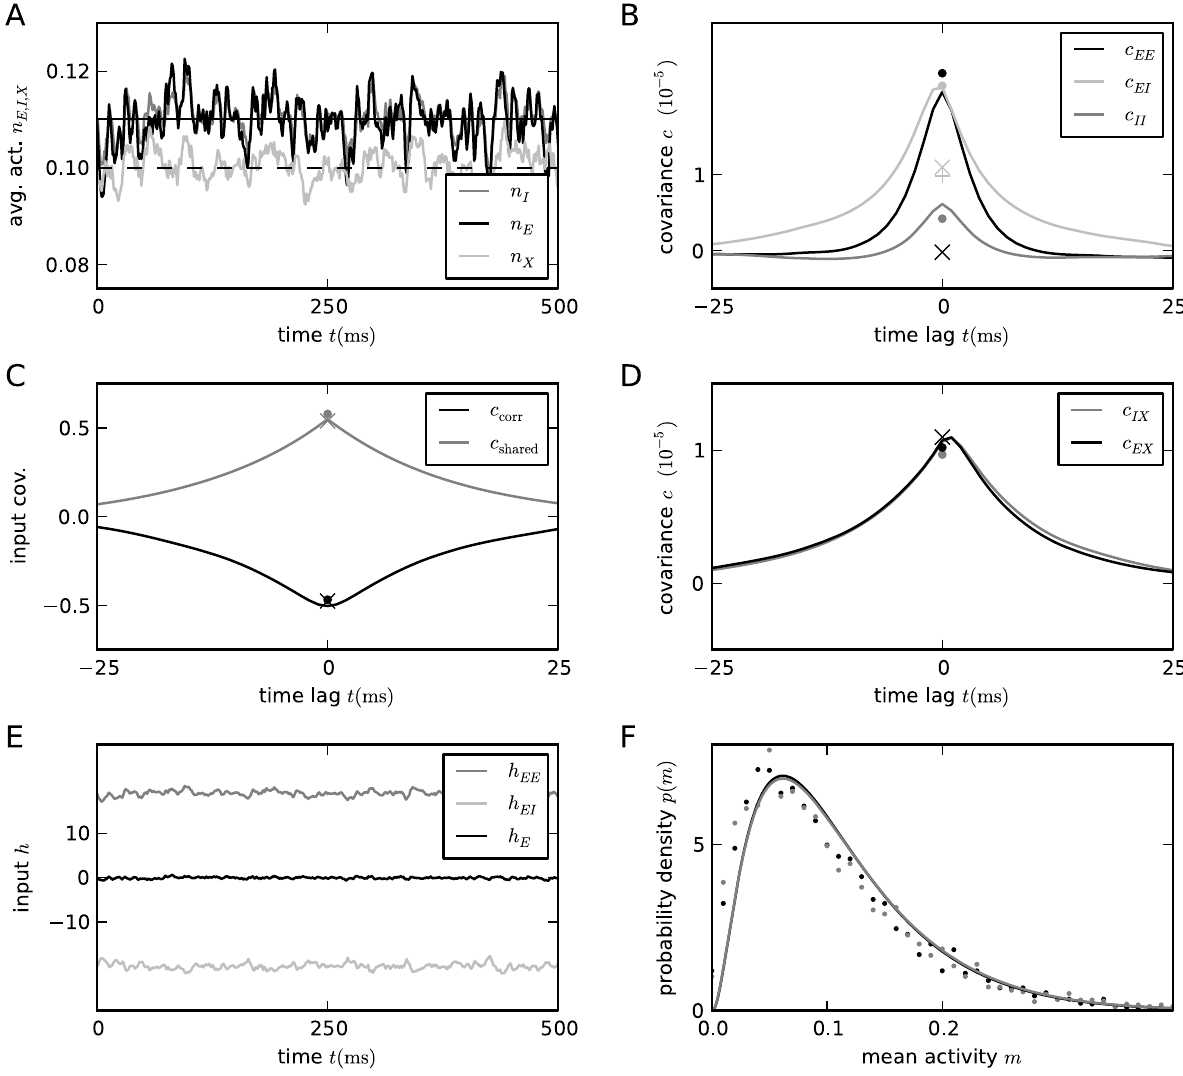
p p Figure 4. Activity in a network of 3 N ~ 3 | 8192 binary neurons as described in [ 24, their Fig. 2 ] , with J EE ~ 5 = ffiffiffiffiffi N , J EI ~{ 10 = ffiffiffiffiffi N , p p p p J IE ~ 5 = ffiffiffiffiffi N , J II ~{ 9 = ffiffiffiffiffi N , J EX ~ 5 = ffiffiffiffiffi N , J IX ~ 4 = ffiffiffiffiffi N . Number K of synaptic inputs binomially distributed as K * B ( N , p ) , with connection probability p ~ 0 : 2 . A Population averaged activity (black E , gray I , light gray X ). Analytical prediction (5) for the mean activities m E ~ m I (dashed horizontal line) and numerical solution of mean field equation (7) (solid horizontal line). B Cross correlation between excitatory neurons (black curve), between inhibitory neurons (gray curve), and between excitatory and inhibitory neurons (light gray curve) obtained from simulation. St. Andrew’s Crosses show the theoretical prediction from [24, supplement, eqs. 38,39] (prediction yields c EE ^ c II ^ { 2 10 { 7 , so only one cross is visible). Dots show the theoretical prediction (24). The plus symbol shows the prediction for the correlation c EI when terms proportional to a E and a I are set to zero. C Correlation between the input currents to a pair of excitatory neurons. Contribution due to pairwise correlations c corr, E (black curve) and due to shared input c shared, E (gray curve). Symbols show the theoretical predictions based on [24] (crosses) and based on (24) (dots). D Similar to B, but showing the correlations between external neurons and neurons in the excitatory and inhibitory population. E Fluctuating input h E averaged over the excitatory population (black), separated into contributions from excitatory synapses h EE (gray) and from inhibitory synapses h EI (light gray). F Distribution of time averaged activity obtained by direct simulation (symbols) and analytical prediction (17) using the numerically evaluated self- consistent solution for the first m E ^ m I ^ 0 : 11 and second moments q E ^ 0 : 019 , q I ^ 0 : 018 (19). Duration of simulation T ~ 100s , mean activity m X ~ 0 : 1 , other parameters as in Figure 3.